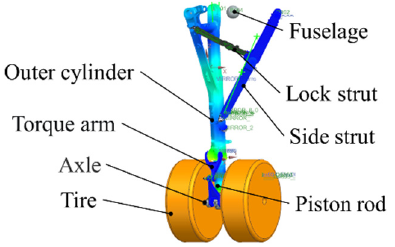
Figure 1. Rigid–flexible coupling dynamics model of a landing gear.